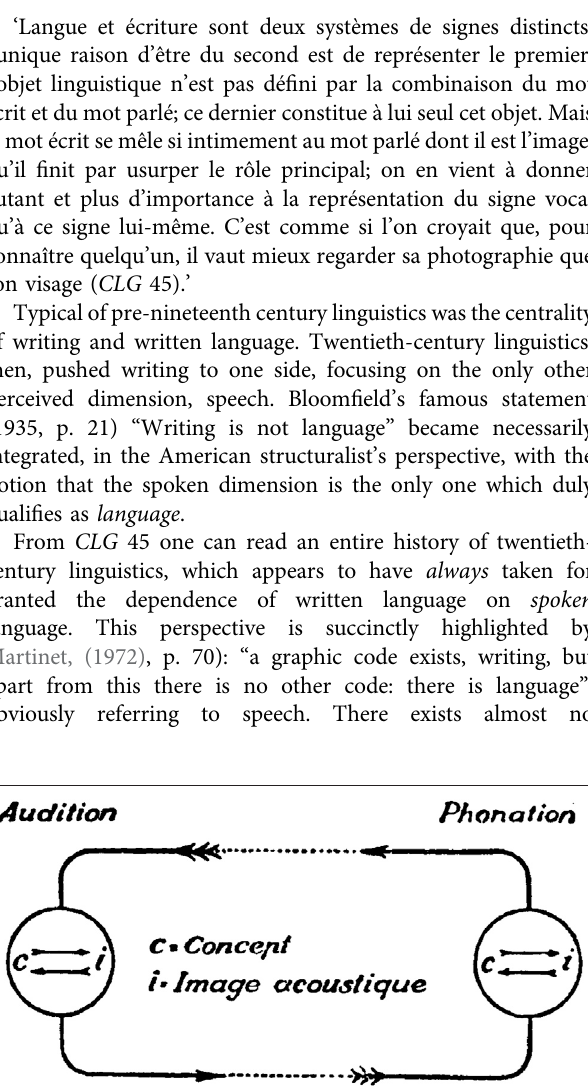
Frontiers in Communication |